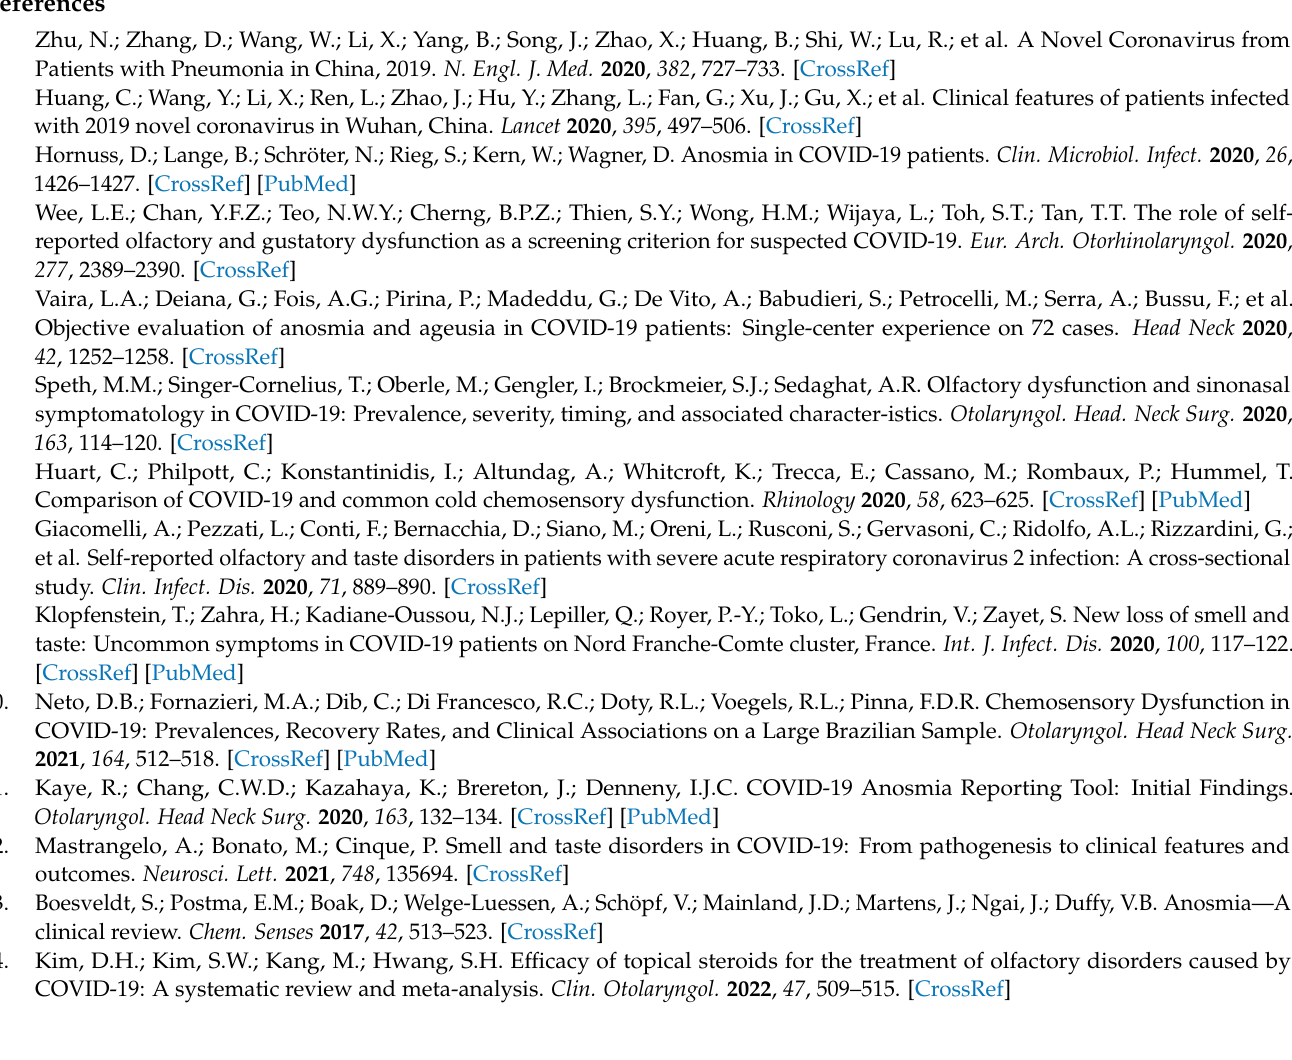
Table S2. COVID-19 course analysis in groups with and without persistent smell and taste disorders. Comparison after propensity score